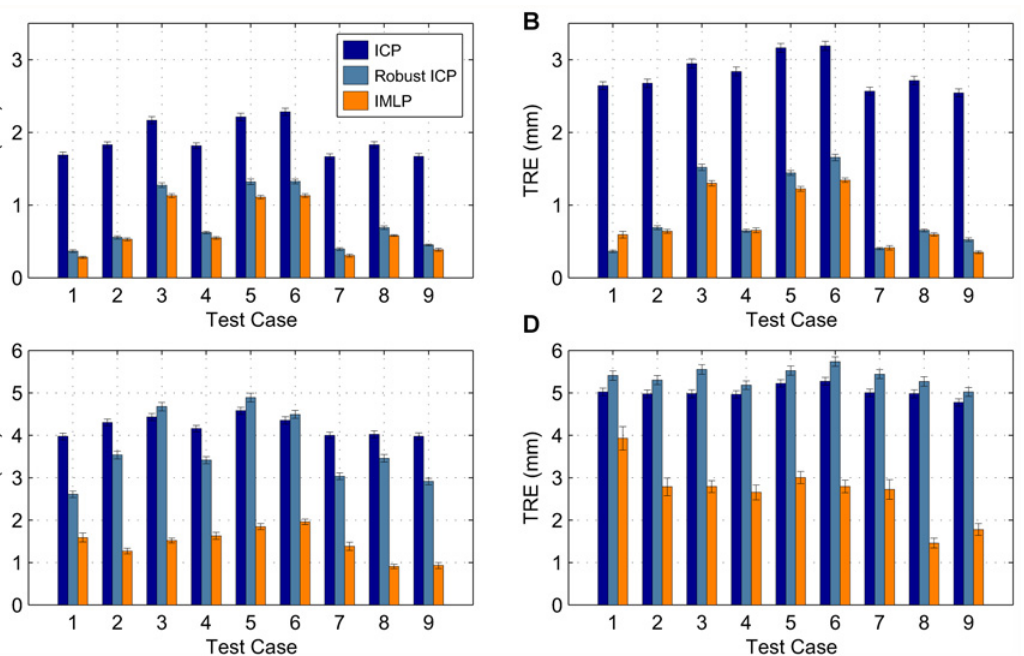
Fig 4. Registration errors for registering a source shape containing outliers to a mesh target under large misalignment. (Experiment 3B). Source shapes were randomly generated from the hip mesh (Fig. 1A), misaligned by [30, 60] mm / degrees, and registered back to the mesh. The test cases represent the different noise models used to generate noise on the source shape (Table 4). Outliers were added to the source shape constituting (A): 5%, (B): 10%, (C): 20%, and (D): 30% of the source points. For each test case, 300 randomized trials were conducted, with successful registrations being used to compute an average target registration error (TRE). The error bars provide approximate standard deviations of the reported average TRE values. The proposed IMLP algorithm was evaluated relative to standard ICP [1] and relative to a robust variant of ICP [4].